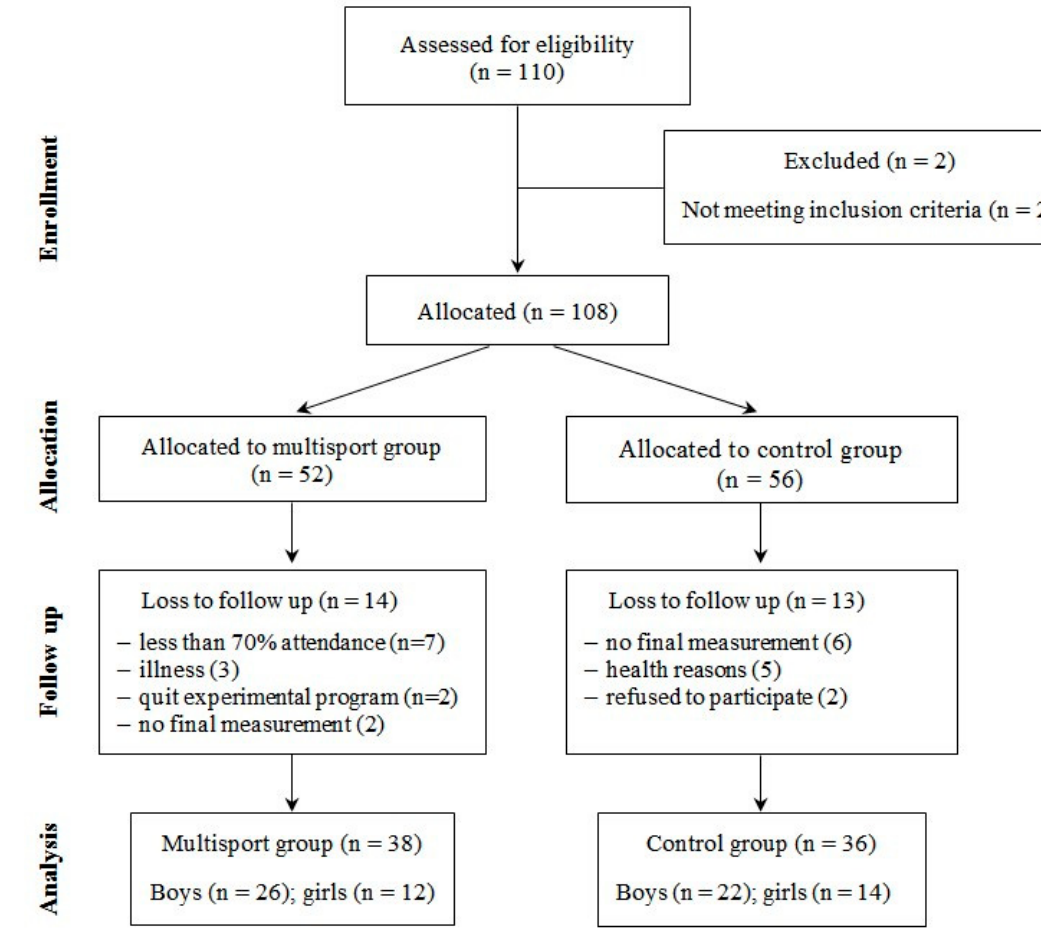
Figure 1. Flow diagram of participant enrolment, randomized group allocation, and final analysis.